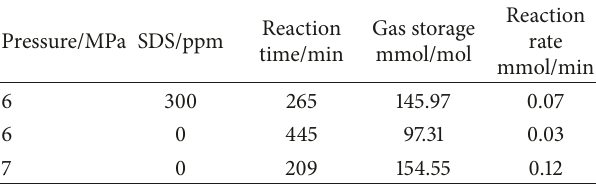
Table 1: Experimental parameters for hydrate formation.